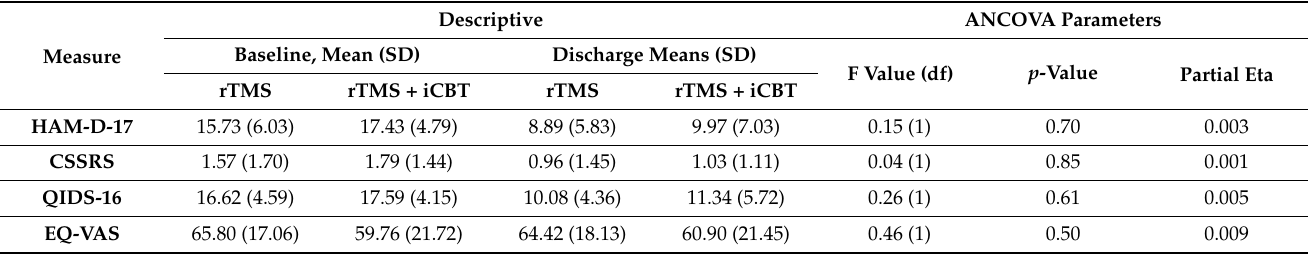
Table 2. Descriptive mean scores of outcome measures and ANCOVA test parameters for the rTMS and rTMS + iCBT